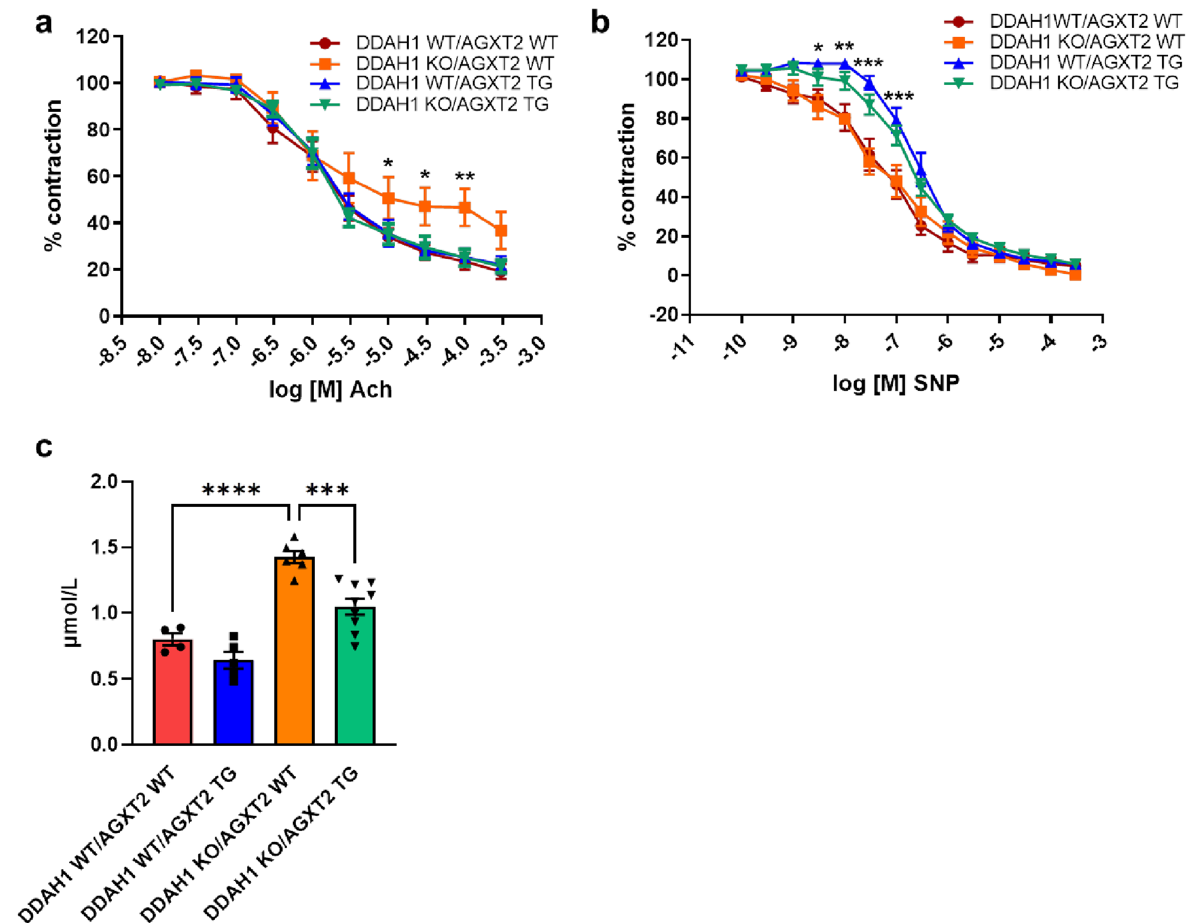
Figure 5. ( a ) Endothelium-dependent and ( b ) -independent vasodilation and ( c ) ADMA plasma levels in DDAH1 KO/AGXT2 WT, DDAH1 KO/AGXT2 WT, DDAH1 WT/AGXT2 TG and DDAH1 KO/AGXT2 TG mice. Ach acetylcholine, SNP sodium nitroprusside. Two-way repeated-measures ANOVA followed by Sidak multiple comparison test ( a , b ), *p < 0.05; **p < 0.01; p < 0.001 DDAH1 KO/AGXT2 WT vs. DDAH1 KO/AGXT2 TG. One-way ANOVA followed by Tukey’s multiple comparison test ( c ), ***p < 0.001; ****p < 0.0001. N = 8–15 ( a , b ), 4–9 ( c ). Cohen’s d = ( c ) 4.6 (DDAH1 WT/AGXT2 WT vs DDAH1 KO/AGXT2 WT) and 2.5 (DDAH1 KO/AGXT2 WT vs DDAH1 KO/AGXT2